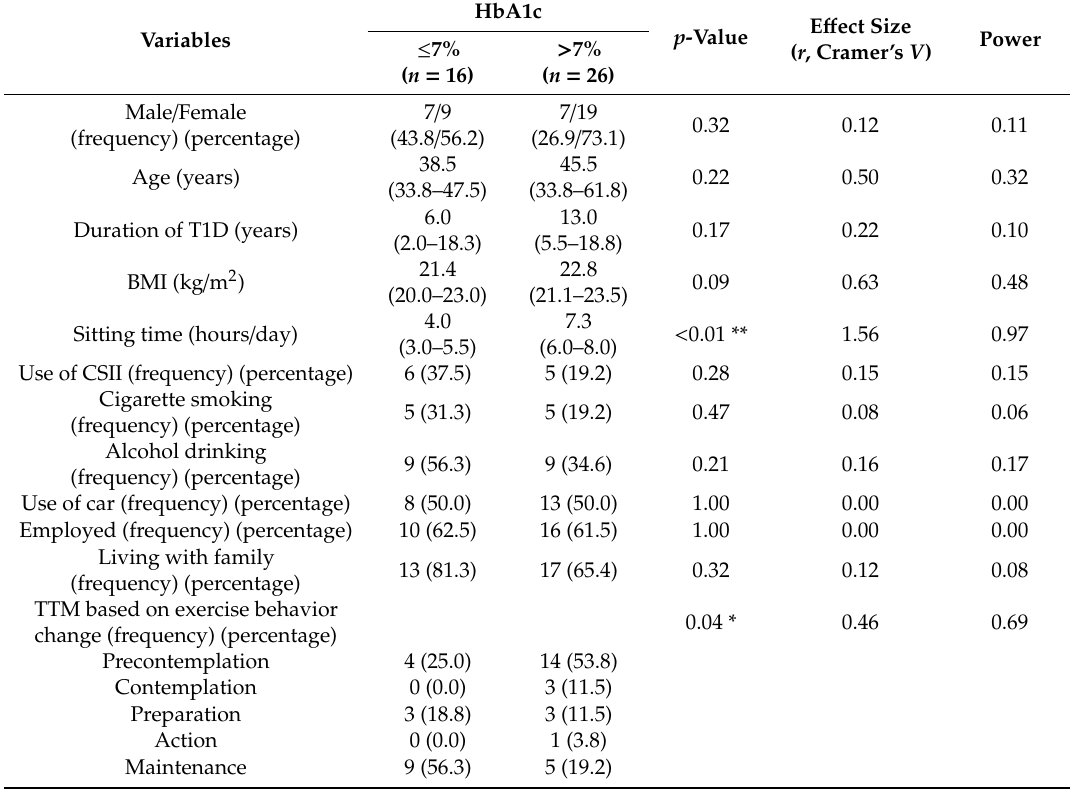
Table 3. Comparisons between the groups with HbA1c ≤ 7.0% and > 7.0%.